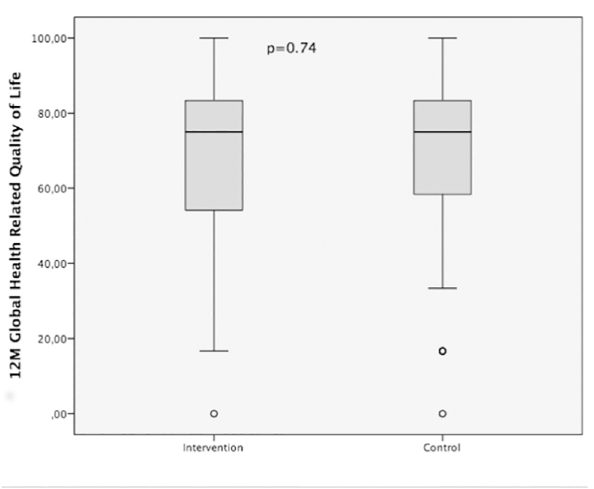
Fig 3. Health-related global quality of life after 12 months for intervention and control groups. HRQoL 12 months after surgery was comparable in intervention and control groups (all patients p =